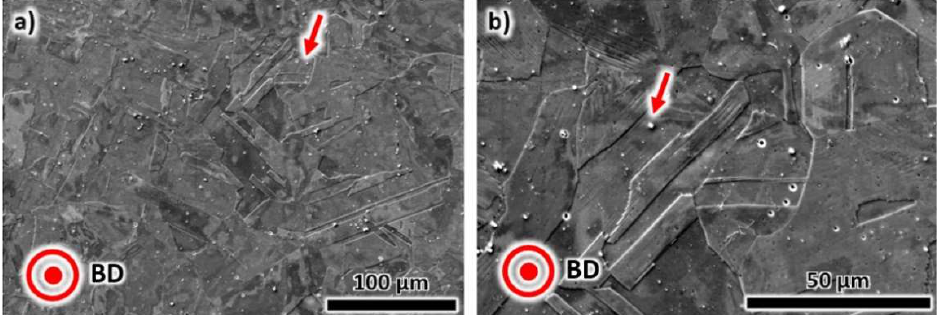
Figure 7. The scanning electron microscopy images of the 316L sample after hot isostatic pressing and annealing heat treatment at ( a ) lower magnification, and ( b ) higher magnification.